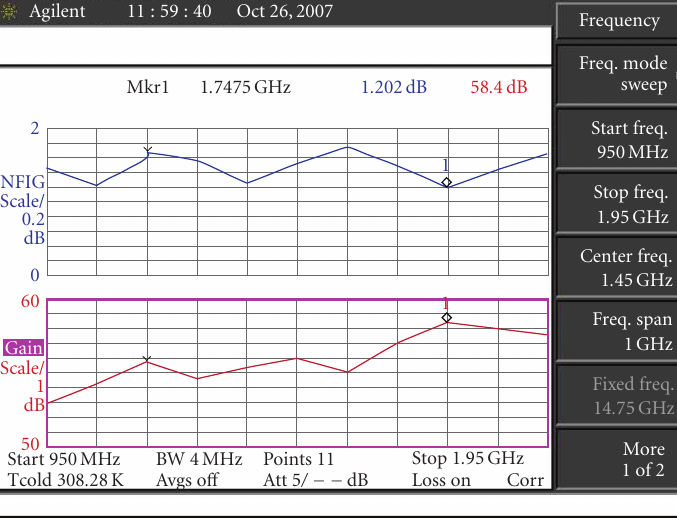
Figure 9: LNB gain and noise